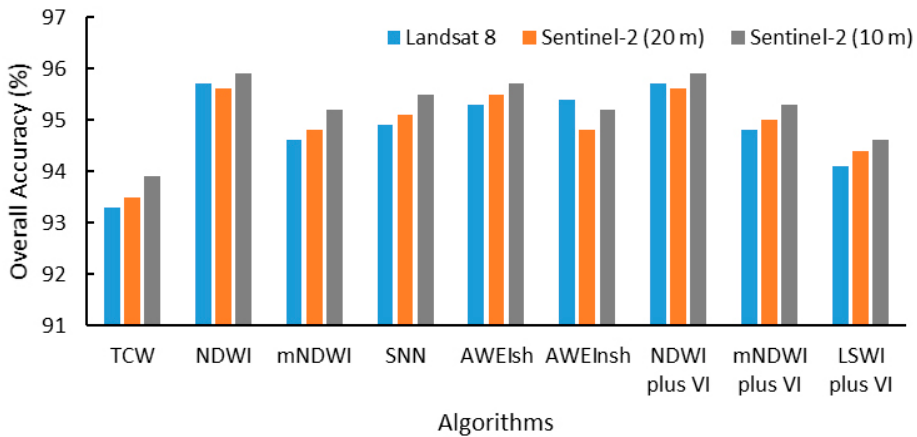
Figure 6. A comparison of overall accuracies based on different data sources (30 m Landsat 8 OLI, resampled 20 m and 10 m Sentinel-2 MSI data) and the nine algorithms.